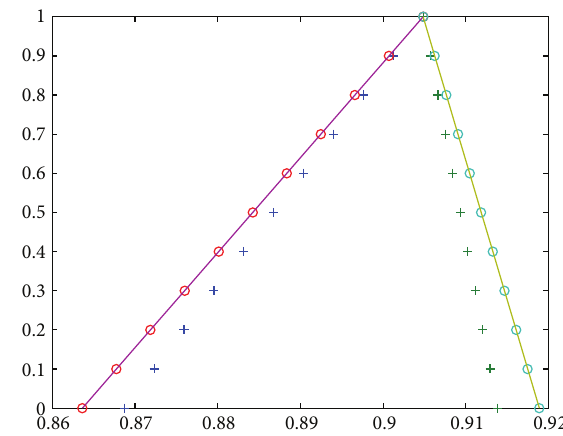
Figure 1: (-) Exact solution, ( ∘ ) Trapezoidal, and (+) Midpoint approximated points.